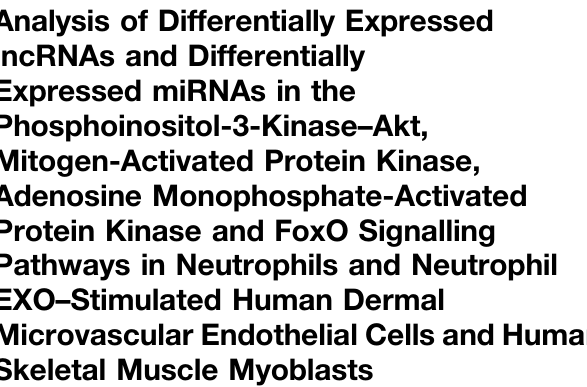
TABLE3| GOandKEGGenrichmentanalysisfortargetgenesofDElncRNAsand DE miRNAs in DM neutrophil exosomes. GO enrichment for target genes of DE